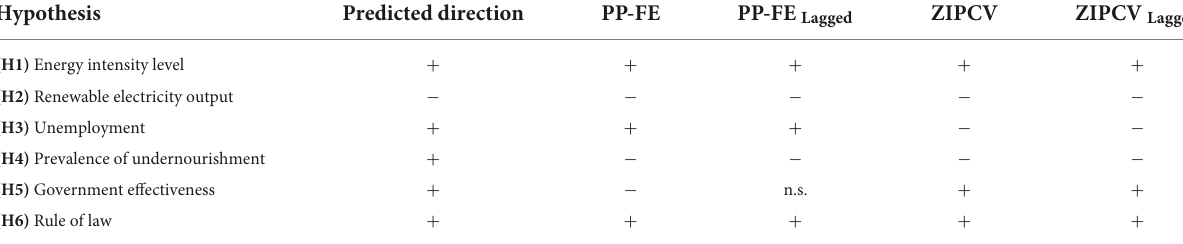
TABLE 10 Summary of hypothesis